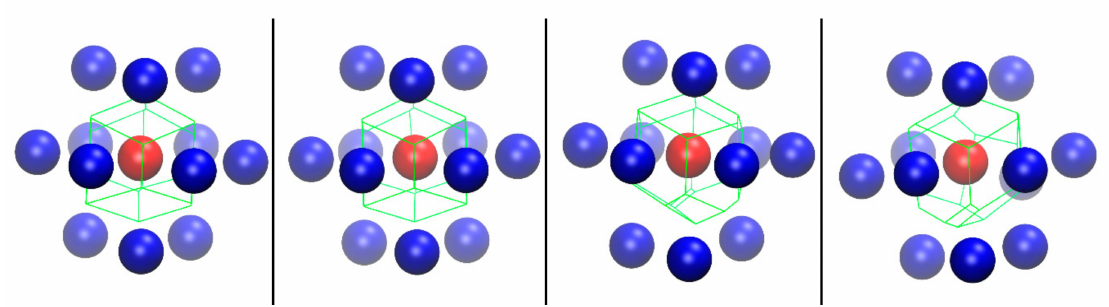
Figure 9. Computer-generated, local structures with progressively reduced HCP-similarity and thus with increasingly high HCP-CCE norm as quantified by the CCE descriptor. From left to right : ε HCP = 0.05, 0.10, 0.20 and 0.30. The latter case is not characterized as HCP-like since ε HCP > ε thres = 0.245. Reference site and nearest neighbors are shown in red and blue, respectively. The corresponding Voronoi polyhedra are also shown as green lines. Sites are shown with reduced diameter in a 2:5 scale for visualization purposes. Image created with the VMD software. Each figure panel is also available as stand-alone image in 3-D, interactive format in the Supplementary